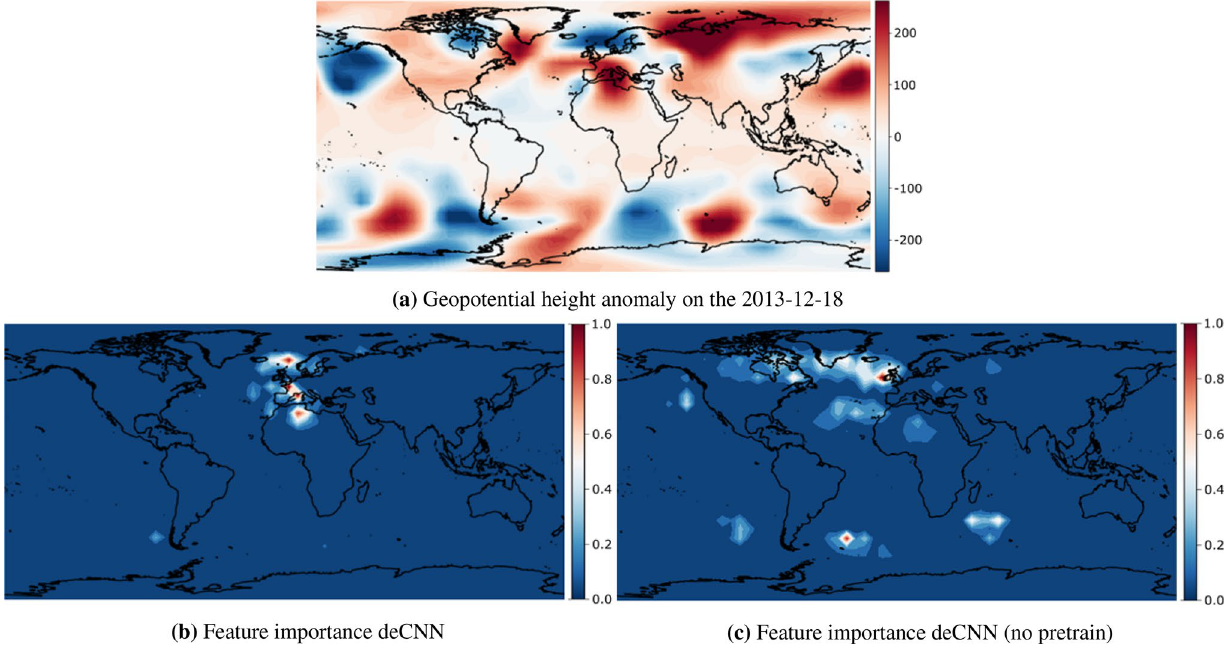
Figure 4. Persistence (i.e., unchanged) transition of NAO+ from the 2013-12-18 to the 2013-12-29. The top ( a ) denotes the geopotential height anomaly input used by our model to make a regime prediction 11 days prior. The lower left ( b ) denotes the relevant regions for making that prediction for the deCNN model, and lower right ( c ) denotes the relevant regions for the deCNN model without transfer learning. Feature importances are normalized to lie between 0 and 1. Figures are created using cartopy 0.19.0 and matlotlib